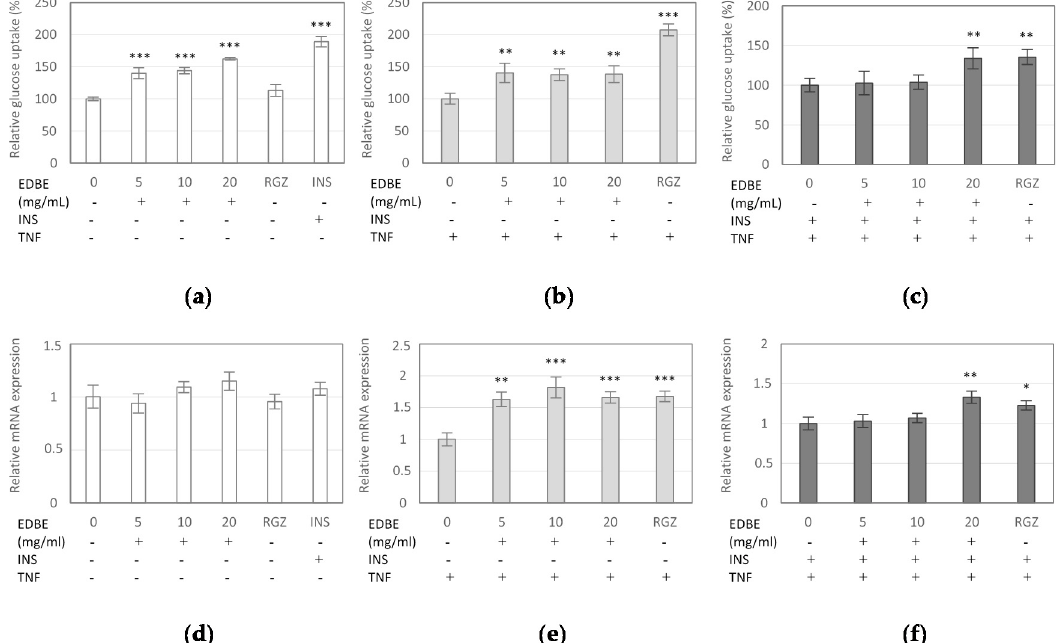
Figure 4. Effect of the elderberry fruit extract (EDBE) on the glucose uptake ( a – c ) and glucose GLUT-4 mRNA expression ( d – f ) in mature 3T3-L1 adipocytes non-induced ( a , d ) and induced by TNF- α transporter GLUT-4 mRNA expression ( d – f ) in mature 3T3-L1 adipocytes non-induced ( a,d ) and ( b–f ) and non-treated ( b , e ) and treated ( c , f ) with insulin (INS). The cells were exposed to EDBE at induced by TNF- α ( b–f ) and non-treated ( b,e ) and treated (c,f ) with insulin (INS). The cells were concentrations of 5, 10, and 20 mg / mL, and to rosiglitazone (RGZ). Data are mean values ± SD ( n = exposed to EDBE at concentrations of 5, 10, and 20 mg/mL, and to rosiglitazone (RGZ). Data are mean values ± SD ( n = 3). The significance of the main effects of EDBE was determined by Tukey post hoc test; the control (INS, RGZ) significance was analyzed by T-student test; * p < 0.05, ** p < 0.01, *** p < 0.001.